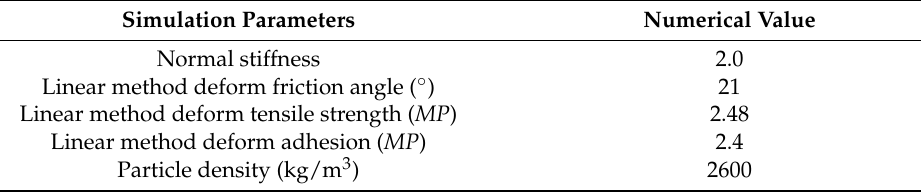
Table 2. Medium weathered calcareous mudstone.